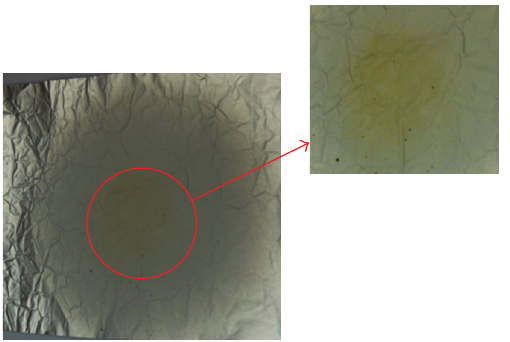
Figure 12: UV-Vis of PVA yarn with nanosilver